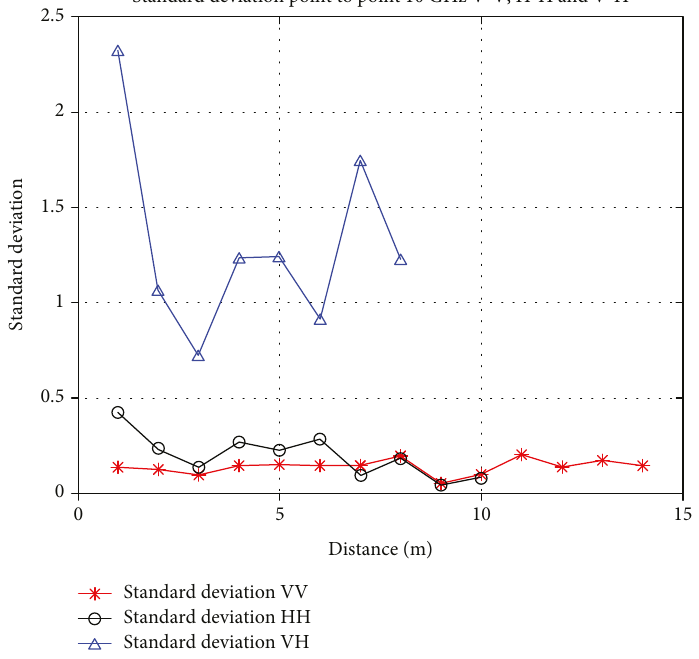
Figure 5: Standard deviation point-to-point data measured in the corridor to V-V, H-H, and V-H.